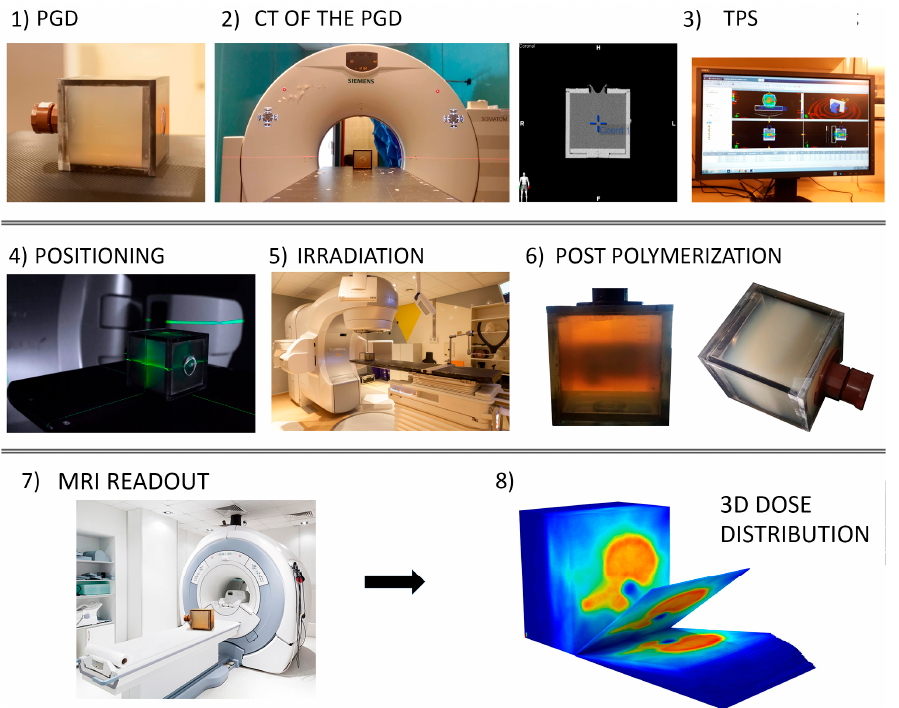
Figure 1. Typical end-to-end application of gel dosimetry. ( 1 ) Gel dosimetry in a cubic phantom (exten- sion to anthropomorphic phantoms is straightforward), ( 2 ) pre-irradiation CT scanning ( 3 ) treatment planning, ( 4 ) positioning, ( 5 ) irradiation, ( 6 ) 3D dosimetry response (post-polymerization processes present only in PGD), ( 7 ) readout of the dosimetry, ( 8 ) final 3D dose distribution generated from the calibration and used gel dosimetry. (Reproduced and adapted with permission from reference [3]). PGD: Polymer Gel dosimetry; TPS: Treatment Planning System; MRI: Magnetic Resonance Imaging; CT: Computed